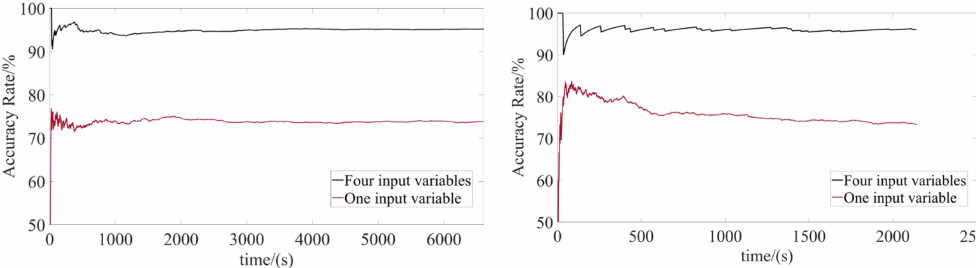
Figure 8. Identification results under real vehicle (( left ): mild, ( right ):